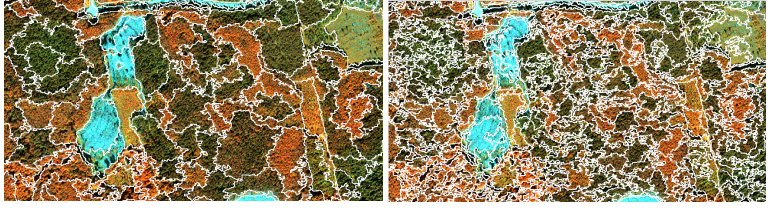
Figure 7. Examples of different segmentation results using GRM (56.51 ◦ N, 24.96 ◦ E: 56.51 ◦ N, 24.97 ◦ E): ( a ) regular grid 48 48 m, ( b ) microstands delineated by the image analyst, ( c ) GRM results using only the GeoEye-1 CHM and D as the optimisation criteria, ( d ) GRM results using only the GeoEye-1 CHM and the RMSE as the optimisation criteria, ( e ) GRM results using only the 4 GeoEye-1 bands and D as the optimisation criteria, ( f ) GRM results using only the 4 GeoEye-1 bands and the RMSE as the optimisation criteria, ( g ) GRM results using combined GeoEye-1 bands, the CHM, and D as the optimisation criteria, and ( h ) GRM results using the combined GeoEye-1 bands, the CHM, and the RMSE as the optimisation